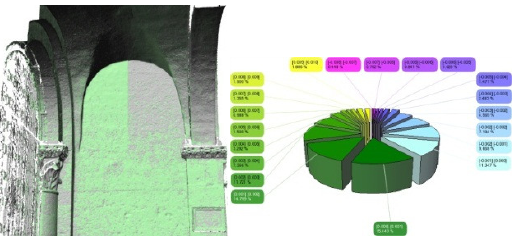
Figure 13. Per mesh color and error pie-chart for sp.